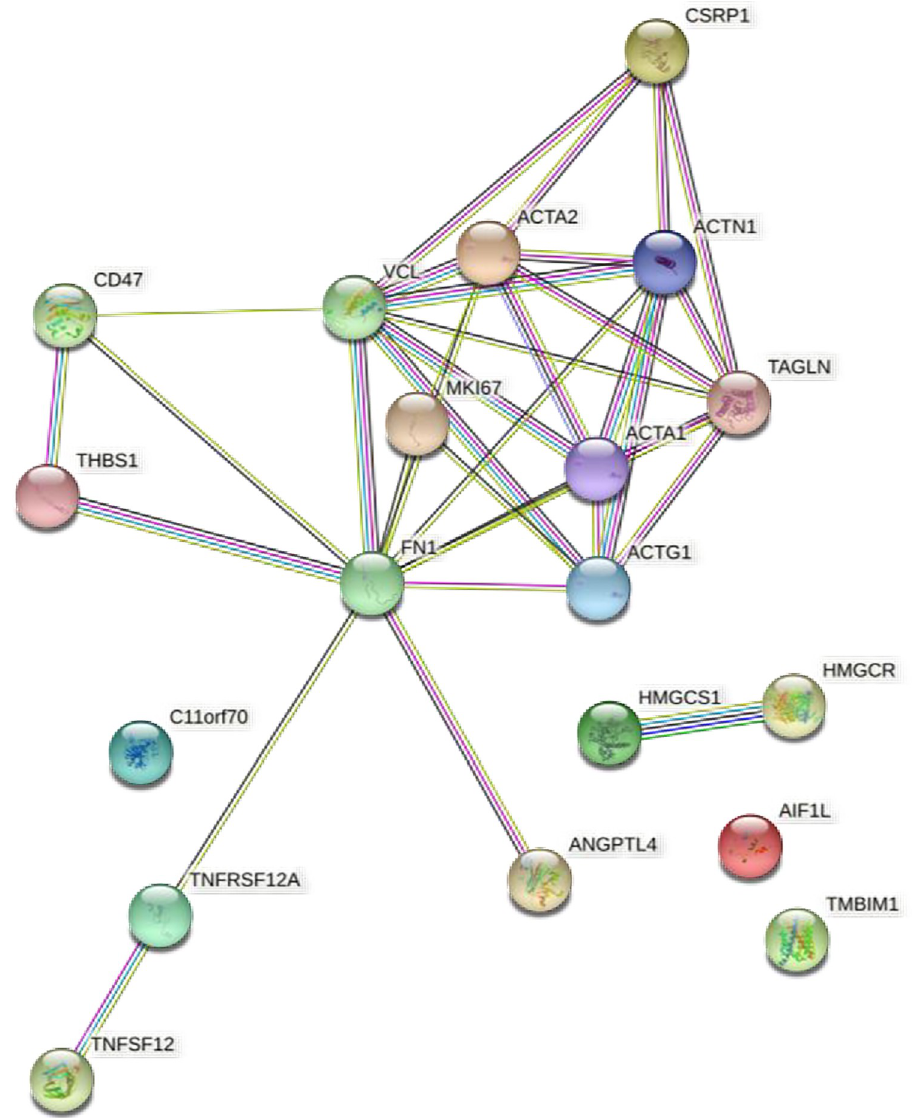
Fig 5. Analysis of protein interaction networks by STRING. We analyzed the protein interaction network using STRING for the 14 genes that were rescued by both inhibitors, as demonstrated by RT-qPCR. Rat gene names were converted to human gene names. As a result, rat LOC654482 was imputed as human C11orf70. From the results shown in S4 Fig, we also added more Predicted Functional Partners to the network. The color of each edge indicates the type of relationship as follows: light blue = "from curated databases"; dark purple = "experimentally determined"; green = "text mining"; black = "co-expression"; and light purple = "protein homology”.